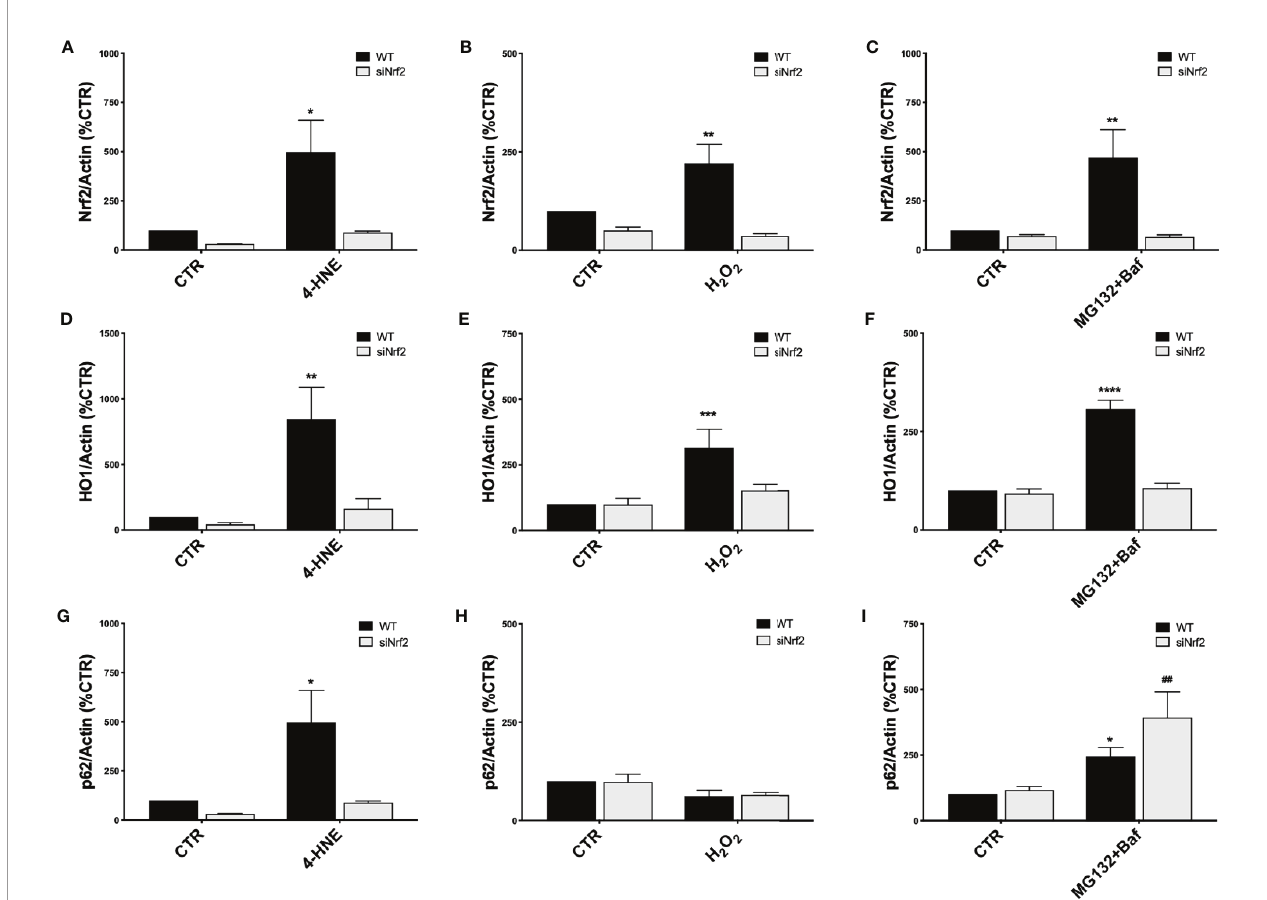
FIGURE 2 | Nrf2-pathway activation in wild type ARPE-19 cells under different stress conditions. Both WT and siNrf2 ARPE-19 cell lines were treated for 6 h with either solvent (DMSO, CTR), 4-HNE [50 m M] (A , D , G) , H 2 O 2 [300 m M] (B , E , H) , or MG132 + Ba fi lomycin [5 m M + 50 nM] (C , F , I) . Total cellular homogenates were examined by Western blot using an antibody against Nrf2 (A – C) , HO1 (D – F) , and p62 (G – I) ; Actin content was used as a loading control to normalize the data. Results are expressed as percentage means ± SEM. Sidak ’ s multiple comparisons test; *p < 0.05, **p < 0.01, ***p < 0.001, and ****p < 0.0001 versus WT CTR; ## p < 0.01 versus siNrf2 CTR; n = 4 –